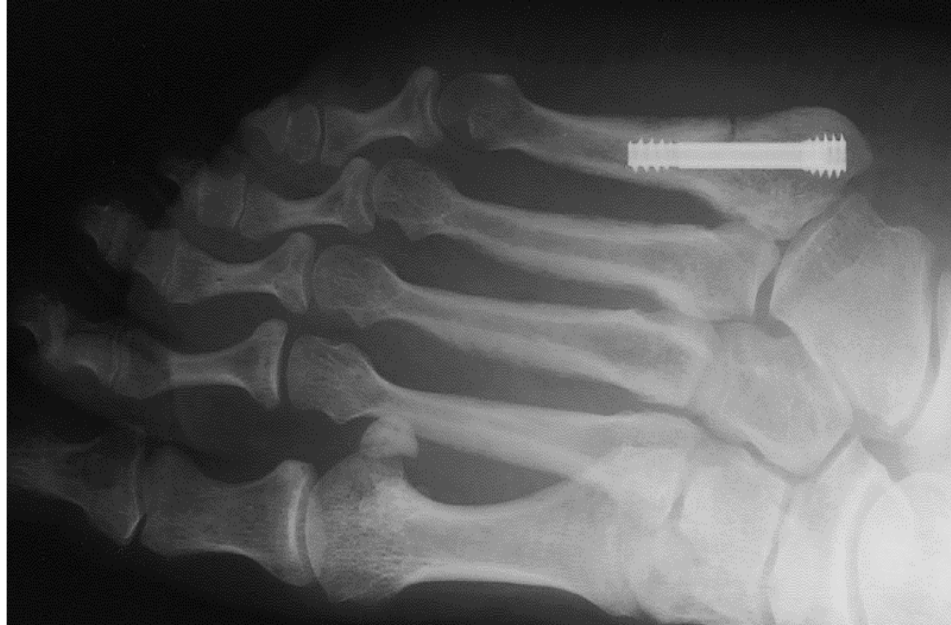
Figure 1. Application of a headless screw to the fifth metatarsal bone. Figure 2 indicates the basic anatomy of the fifth metatarsal bone and its surroundings.